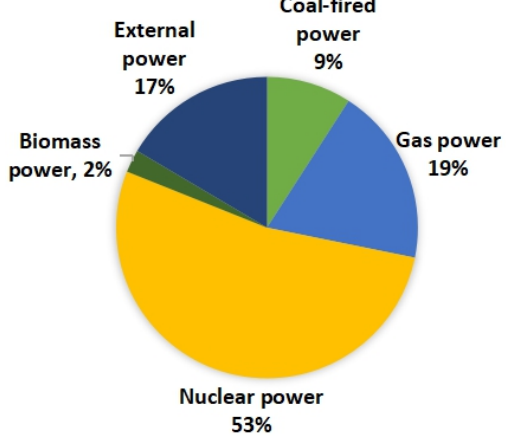
Figure 2. Energy components in Shenzhen in 2015.